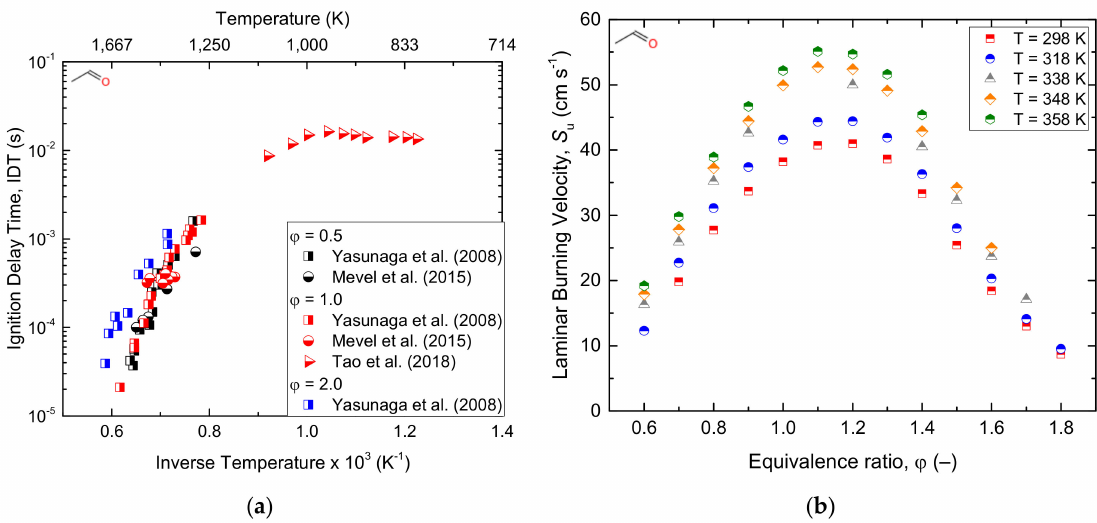
Figure 12. Ignition delay time ( a ) and laminar burning velocity ( b ) of the acetaldehyde/air mixture under different conditions. Note that laminar burning velocity measurements refer to the data reported by Christensen and Konnov [14] exclusively.